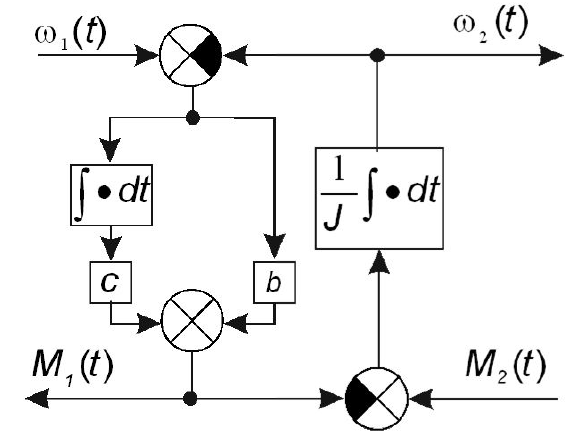
Figure 12. Mass and spring mathematical represen- tation